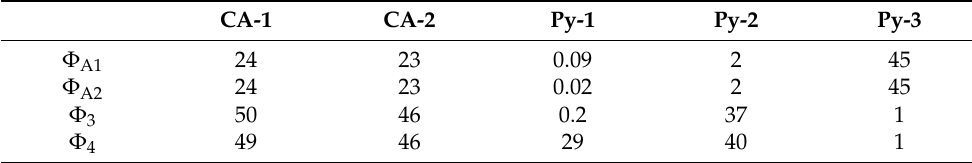
Table 1. Calculated Critical Dihedral Angles of New Sensitizers at Ground State (S0) Geometry. CA-1